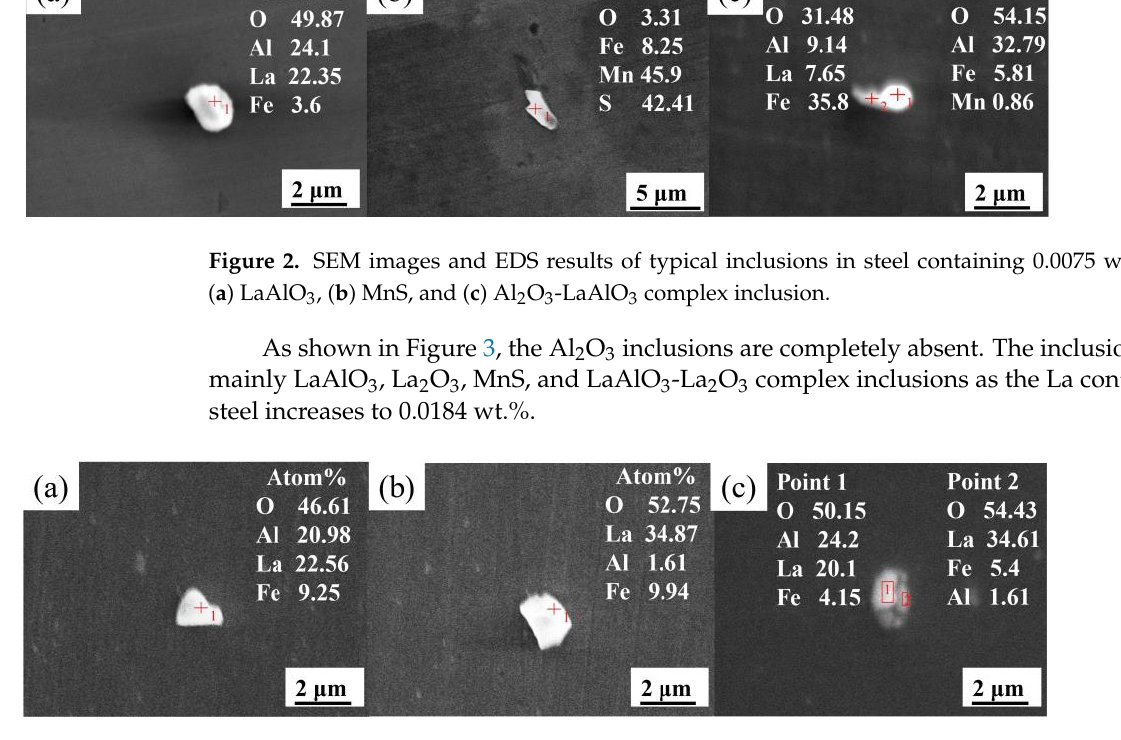
Figure 1. SEM images and EDS results of typical inclusions in RE-free steel: ( a ) Al 2 O 3 , ( b ) MnS, and ( c ) Al 2 O 3 -MnS complex inclusion.